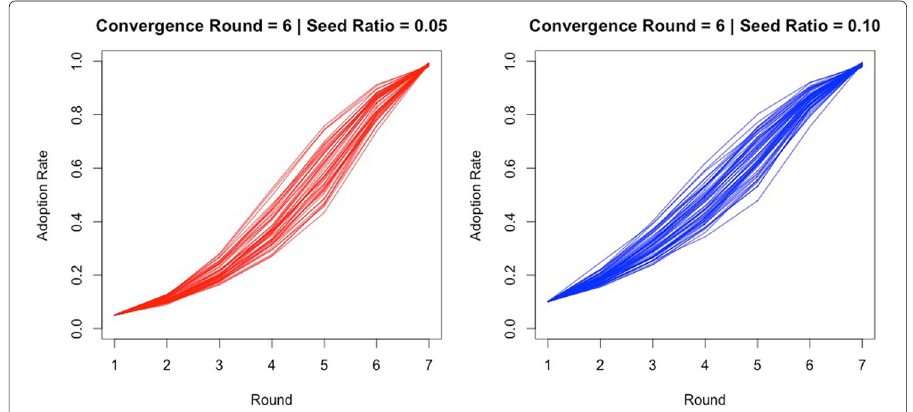
Fig. 5 S-shaped diffusion curves (convergence round =6)